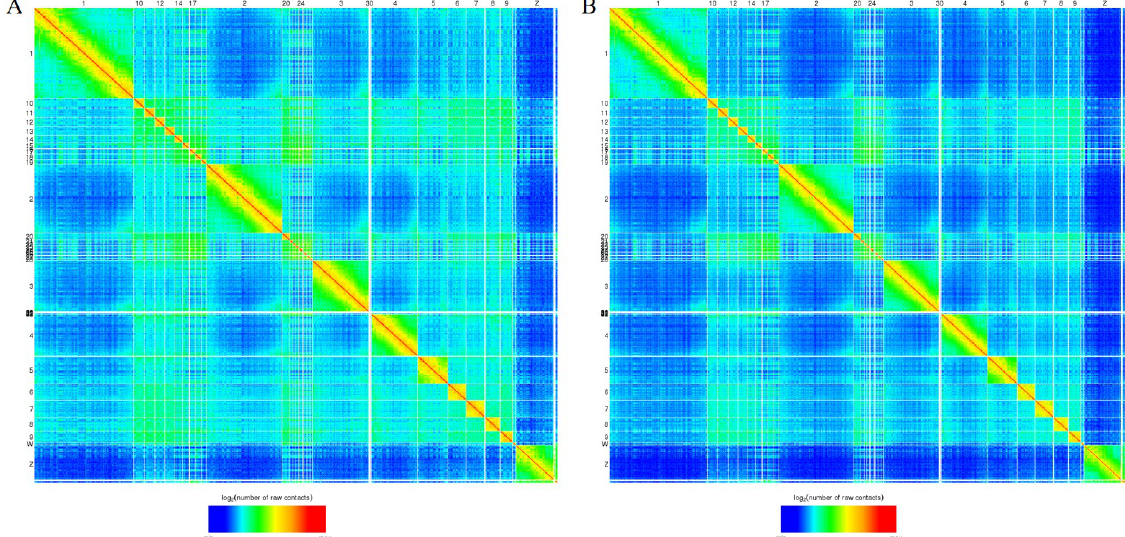
Figure 1. Hi-C contact heatmaps of liver cells in LDC ( A ) and WCC ( B ). The color of each dot on the heatmaps represents the log of the interaction probability for the corresponding pair of genomic loci according to standard JuiceBox color scheme.